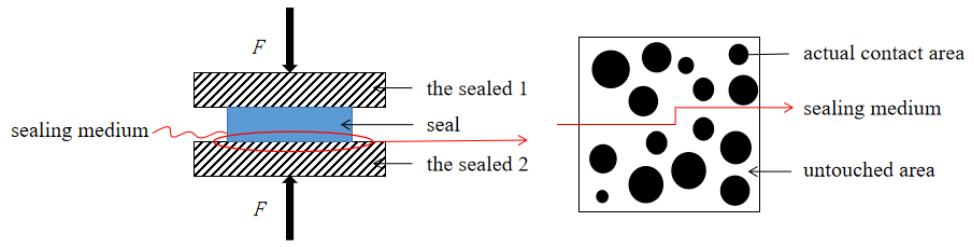
Figure 1. Schematics of seepage theory and interface leakage.